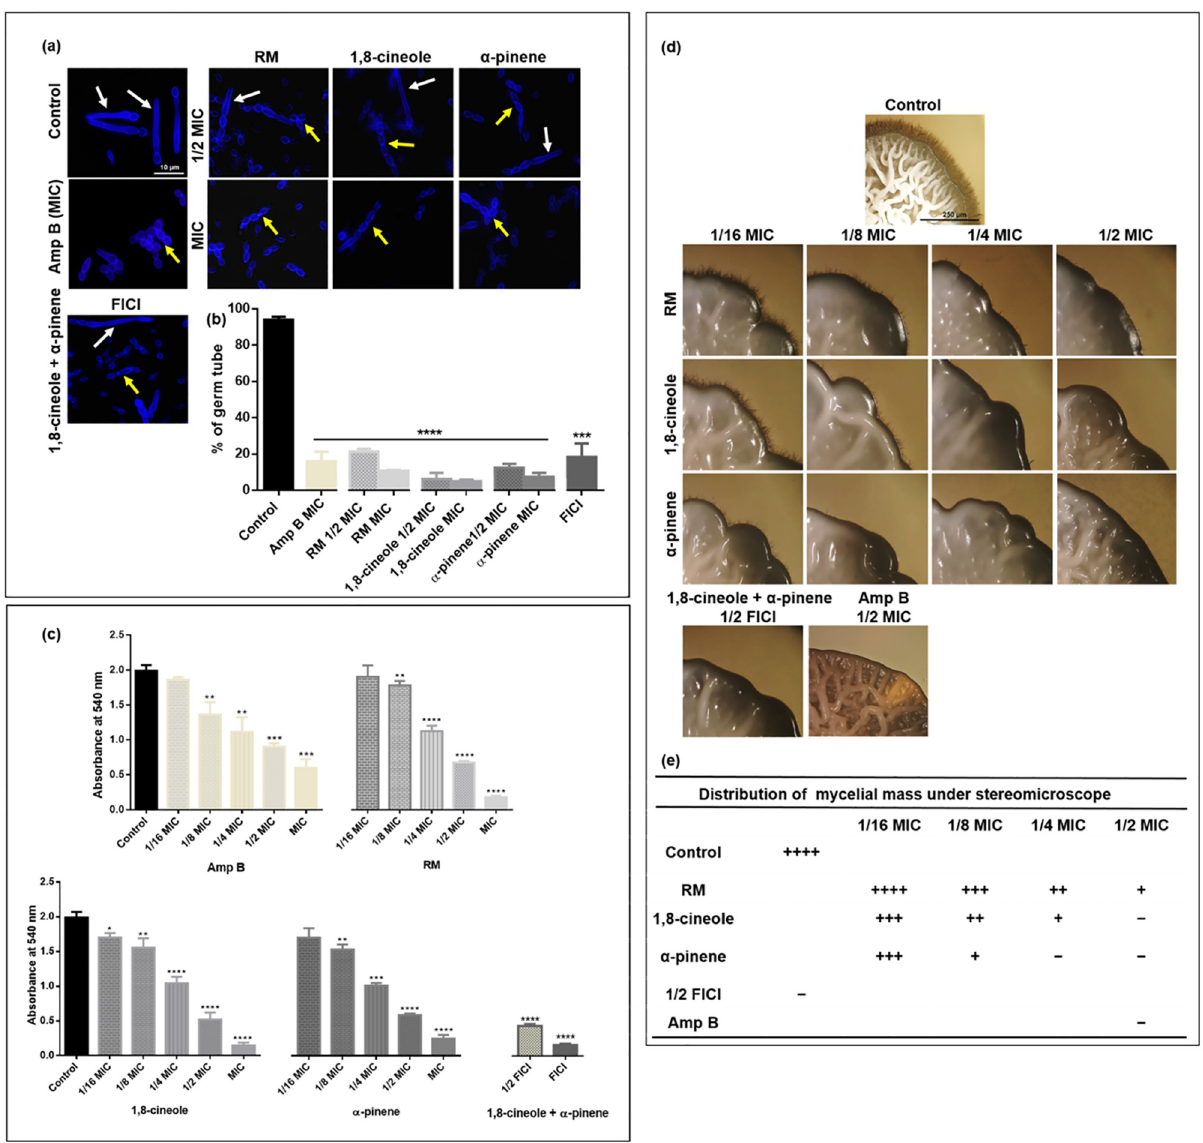
Fig 7. RM oil and its components impact C . albicans RSY150 germ tube, mycelium formation and preformed biofilm. (a) Representative fluorescence microscopy ( λ ex = 365 nm; λ em = 435 nm) images show that C . albicans treated with 10% FBS in YPD medium containing either RM oil, 1,8-cineole or α -pinene at 1/2 MIC or MIC, or the latter at their FICI (4 h exposure) form pseudohyphae (yellow arrows), while control cells mostly produced germ tubes (white arrows). Scale bar for the control is 10 μ m and applies to all images. (b) Bar graphs show all EO(C)s inhibit the yeast to hyphal transition in C . albicans . (c) Bar diagram of the MTT assay shows a dose dependent (r = 0.95–0.99, p < 0.001 for all conditions, FICI: r = 0.86, p < 0.05) biofilm reduction after treatment with RM oil, 1,8-cineole, and α -pinene. Data are presented as the mean ± SEM of three biological replicates, with 100 cells per replicate, for which statistical significance ( ���� , p < 0.0001; ��� , p < 0.001; �� , p < 0.01; � , p < 0.05) was analysed by (b) an unpaired Student’s t -test and (c) a one-way ANOVA, followed by Dunnett’s multiple comparison of each condition versus control. (d) Representative stereoscopic bright-field images of control and treated RSY150 on spider media. Bar for control is 250 μ m, and represents the scale for all images. (e) Results are summarized in tabular format for which ++++, +++, ++ and + indicate the relative amount of mycelial